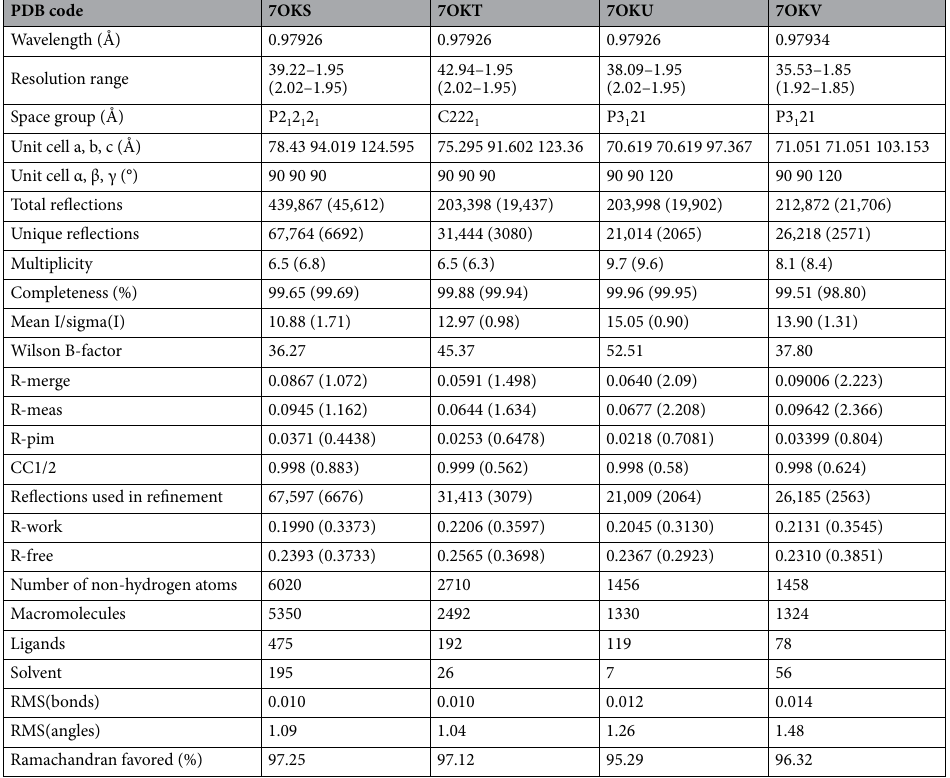
Table 1. X-ray data collection, processing, and refinement statistics. Values in parentheses are for highest resolution